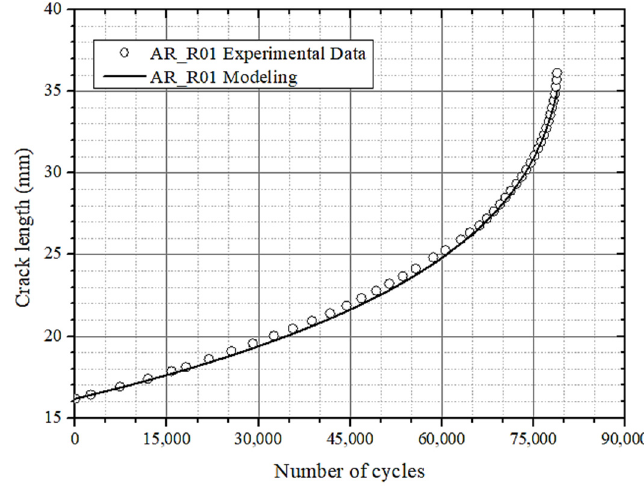
Figure 10. Crack length vs. number of cycles for AR-R01: experimental results and modeling.